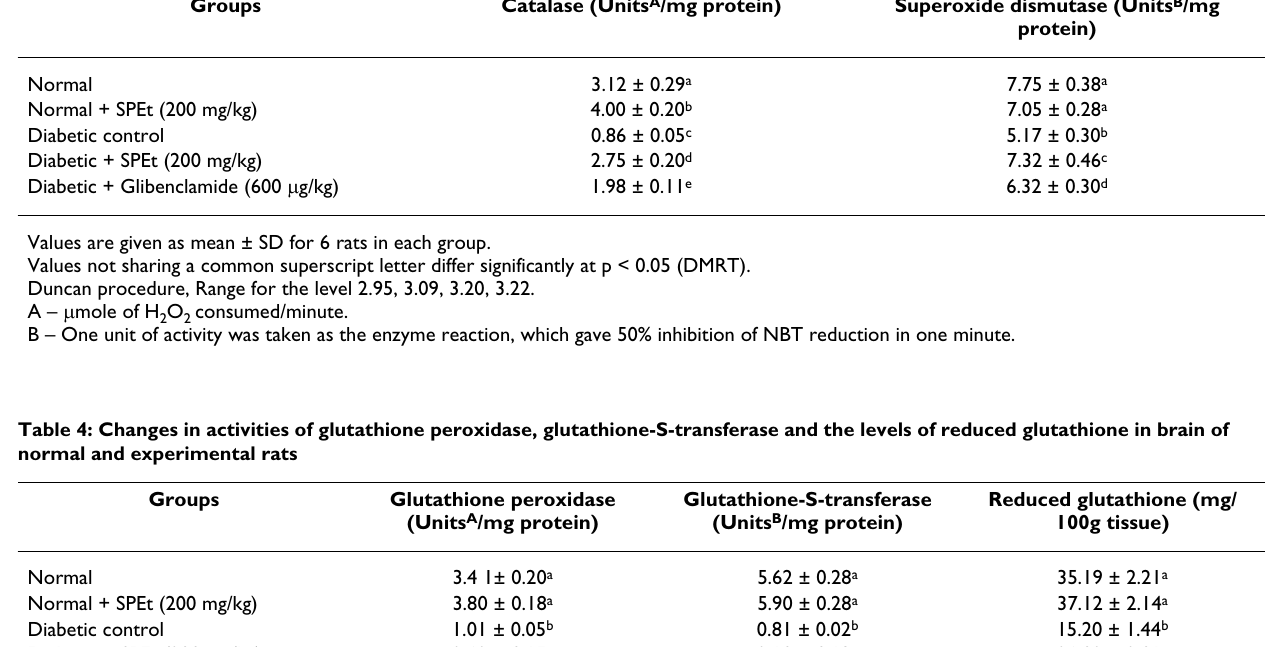
Table 3: Changes in activities of catalase and superoxide dismutase in brain of normal and experimental rats Groups